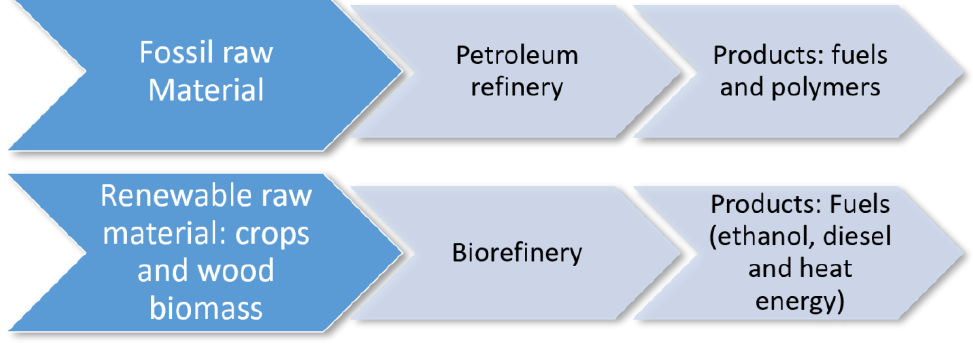
Figure 4. Comparison between biorefinery and oil refinery [27].